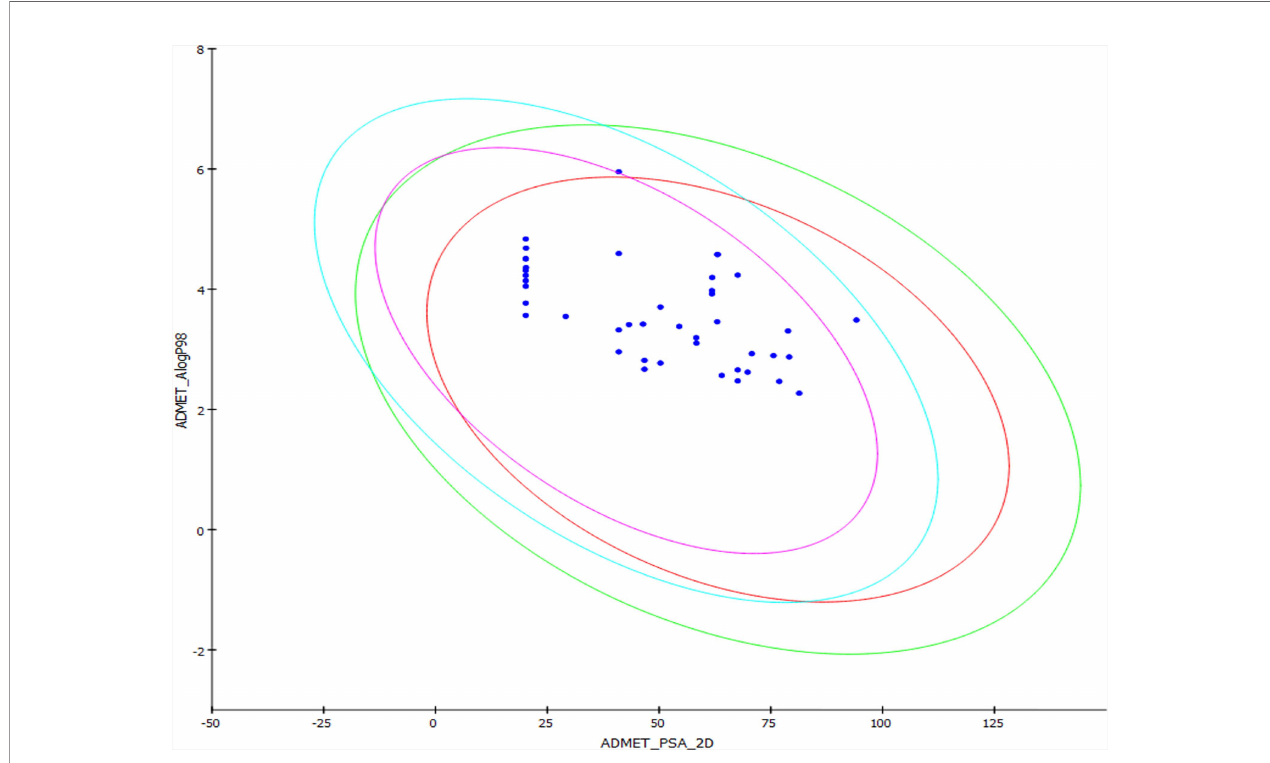
FIGURE 3 | ADME/T evaluation plot of PSA vs AlogP for 38 lead molecules; 99% and 95% con fi dence limits correspond to intestinal absorption and blood – brain barrier